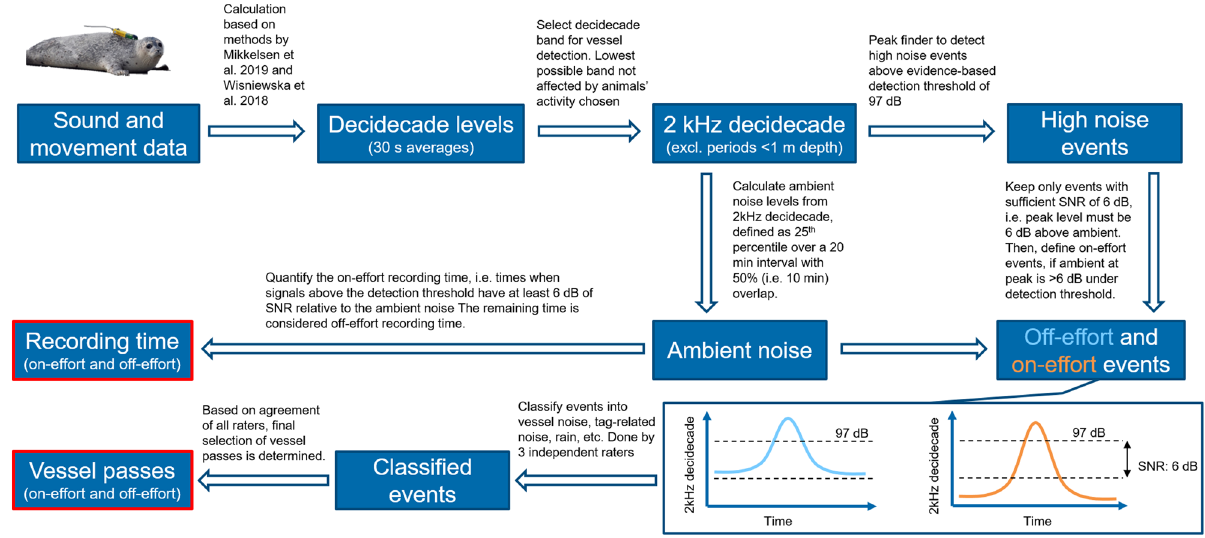
Figure 1. Workflow of the detection and classification of vessel passes, and definition of on-effort and off-effort